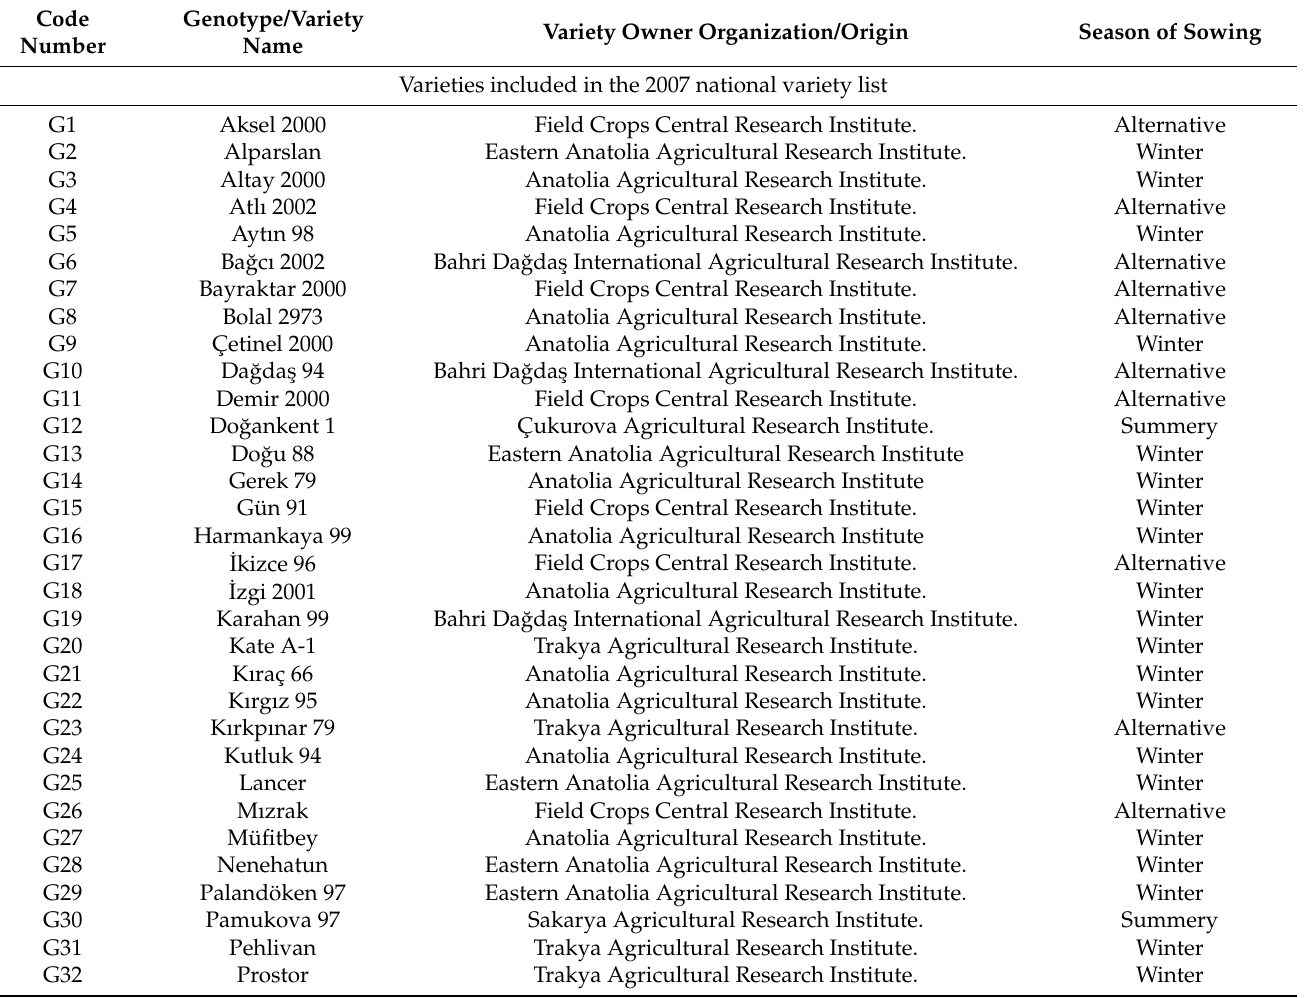
Table 1. Some information about the bread wheat varieties used in the